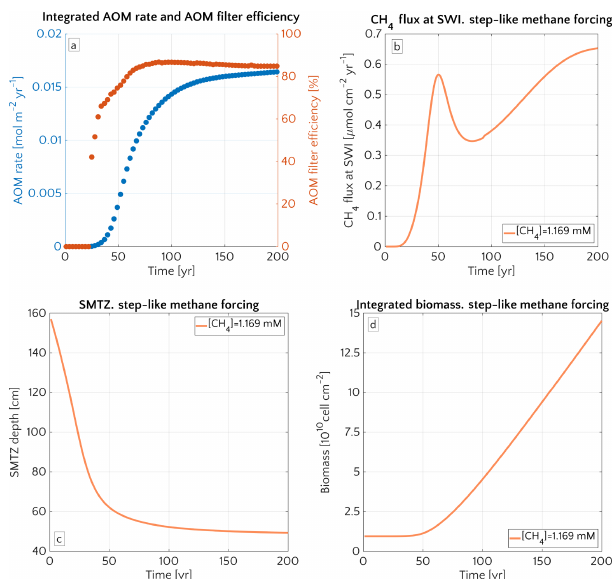
Figure 8. Time evolution over 200 years for the case of an ac- tive set-up with v up = 1cmyr − 1 and a step-like methane forcing from below from 0 to [ CH 4 ] − = 1 . 169mM. (a) AOM vertically integrated rate (blue) and AOM efficiency (red). (b) CH 4 flux at SWI. (c) SMTZ depth. (d) Vertically integrated biomass (number of cells).